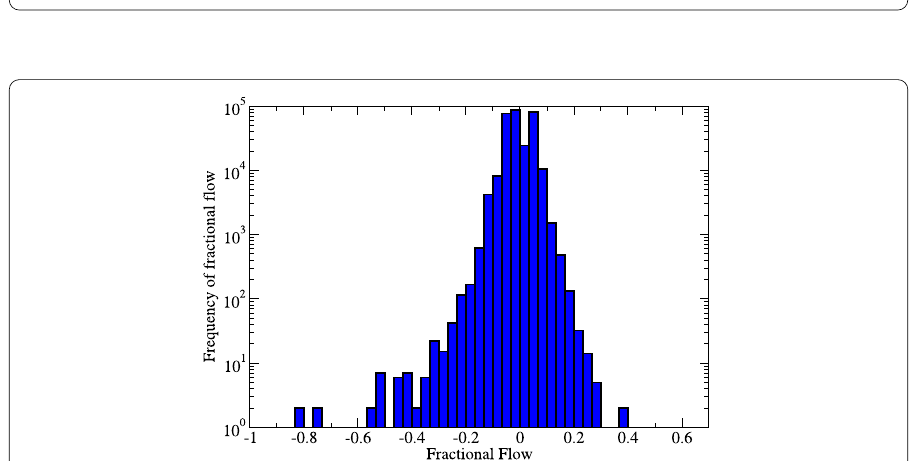
Figure 23 Histogram of fractional net flows with respect to firm size for the Finnish dataset. The results are concentrated around 0, supporting the steady state